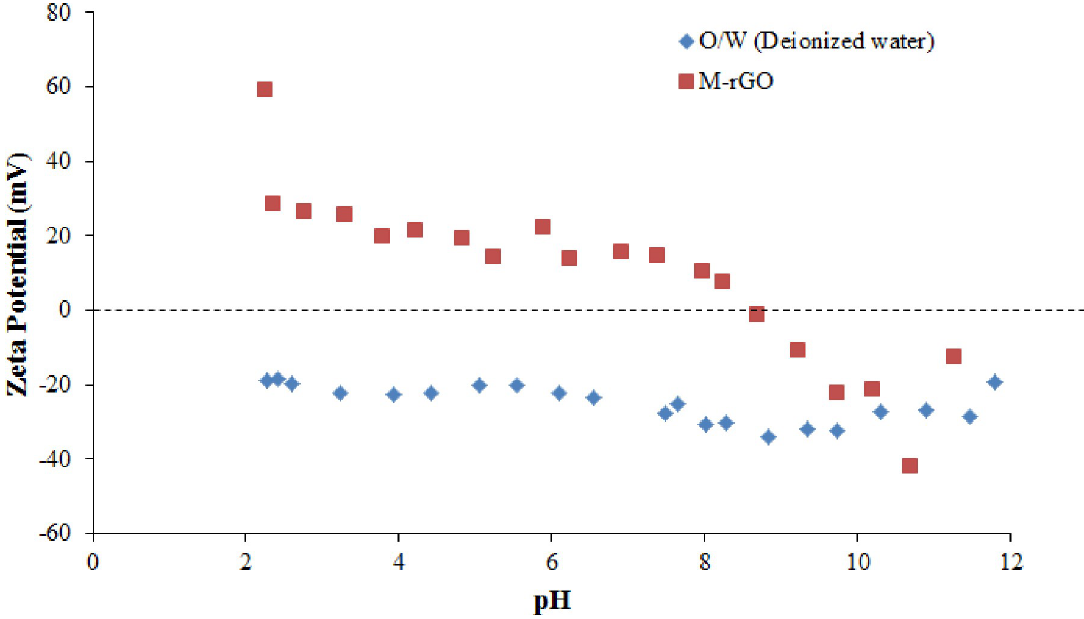
Fig 13. Zeta potential of M-rGO nanocomposites and crude O/W emulsion at various pH values.